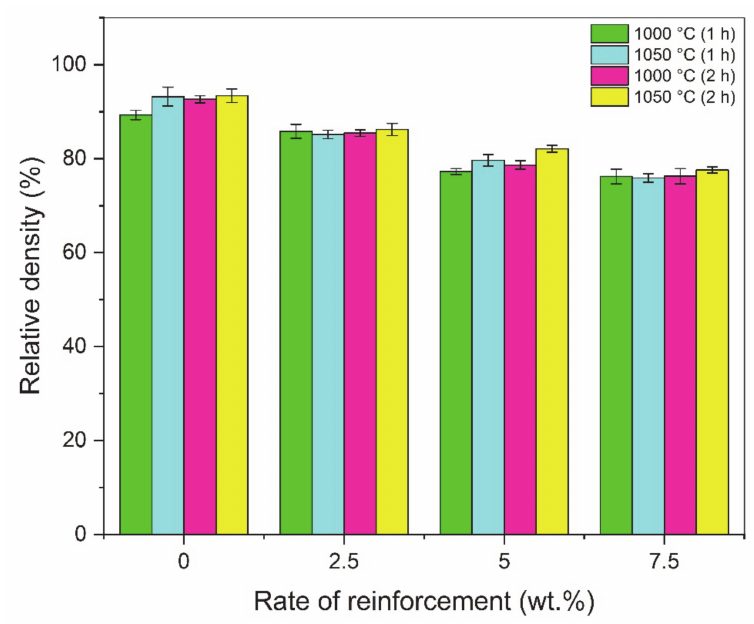
Figure 6. Relative density graph of composites sintered at different times and temperatures.